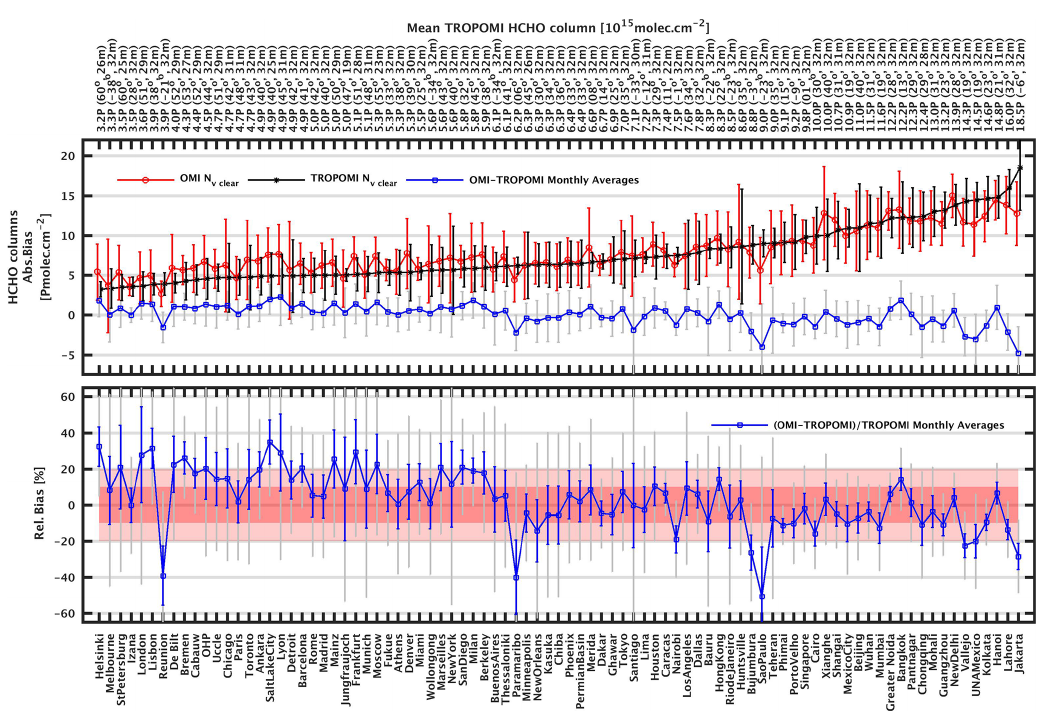
Figure 9. Absolute and relative biases between OMI and TROPOMI HCHO monthly averaged tropospheric columns using clear-sky AMF ( N v_clear ) within 20km radius circles around selected cities, sorted as a function of the median TROPOMI HCHO column. Values of the averaged HCHO columns are provided on the top axis as are the numbers of months taken for the comparison and the latitude of the region. The median OMI (red) and TROPOMI (black) columns are plotted together with the absolute differences (in blue). Error bars represent the median absolute deviations (MADs) of the columns and of the differences (in grey). Statistical ErrB is also plotted for the relative bias (in blue). Pink areas indicate 10% and 20% bias. (Pmolec.cm − 2 = 1 × 10 15 molec.cm − 2 .) Table 2. Median absolute deviation of the OMI and TROPOMI daily and monthly averaged columns ( N v_clear ), in large regions and in a 20km radius area. MADs of differences between OMI and TROPOMI columns are also given in the last column. Dispersion OMI MAD TROPOMI MAD OMI-TROPOMI MAD [10 15 molec.cm − 2 ] [10 15 molec.cm − 2 ] [10 15 molec.cm − 2 ] Monthly regional Daily